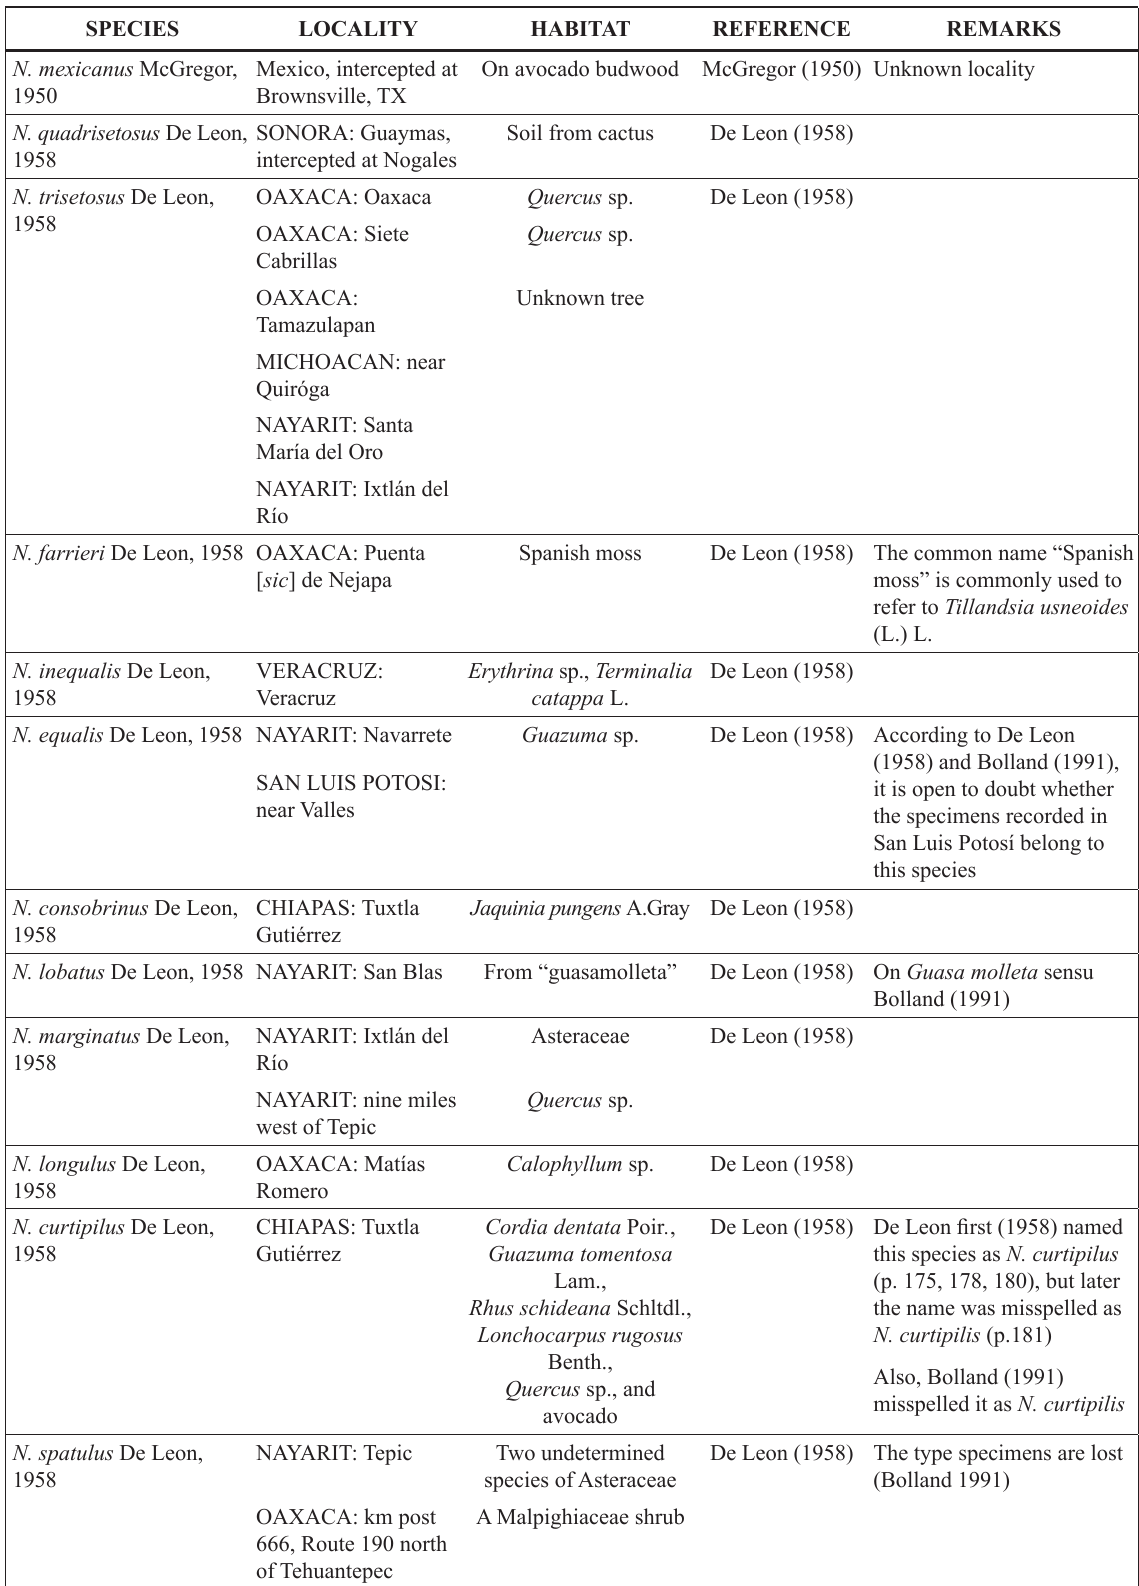
Table 1. Species of Neophyllobius Berlese, 1886 recorded in